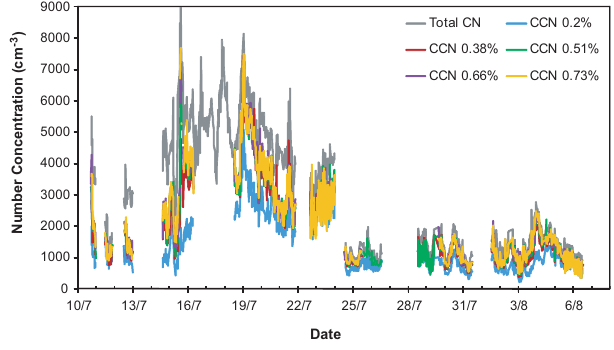
Fig. 4. Time series of the CN and CCN measurements throughout the measurement